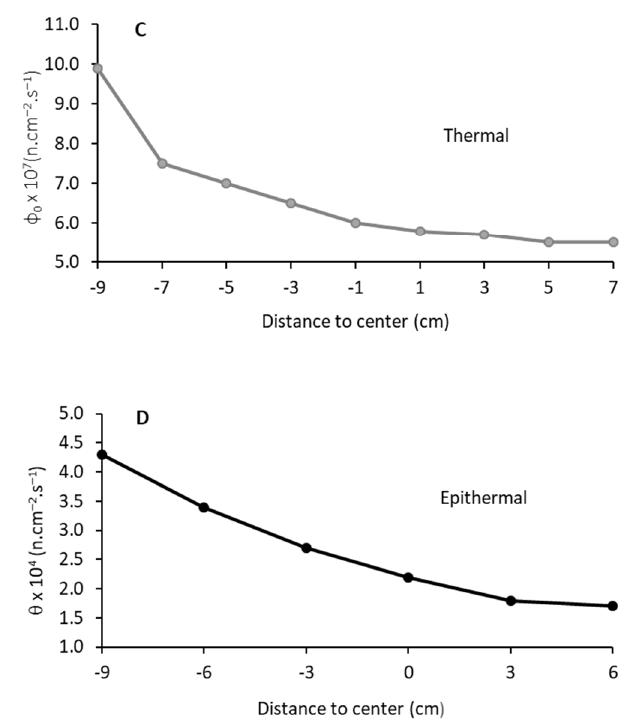
Figure 4. Neutron fluence rate distribution on the x axis ( A , B ) and y axis ( C , D ), normalized at 1 MW reactor power.